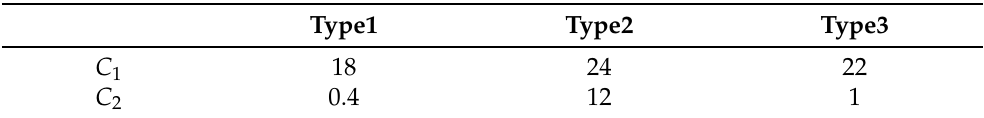
Table 4. Values of C 1 and C 2 used for the three sediment types. The typical values of C 1 and C 2 are 18 < C 1 < 24 and 1 < C 2 <